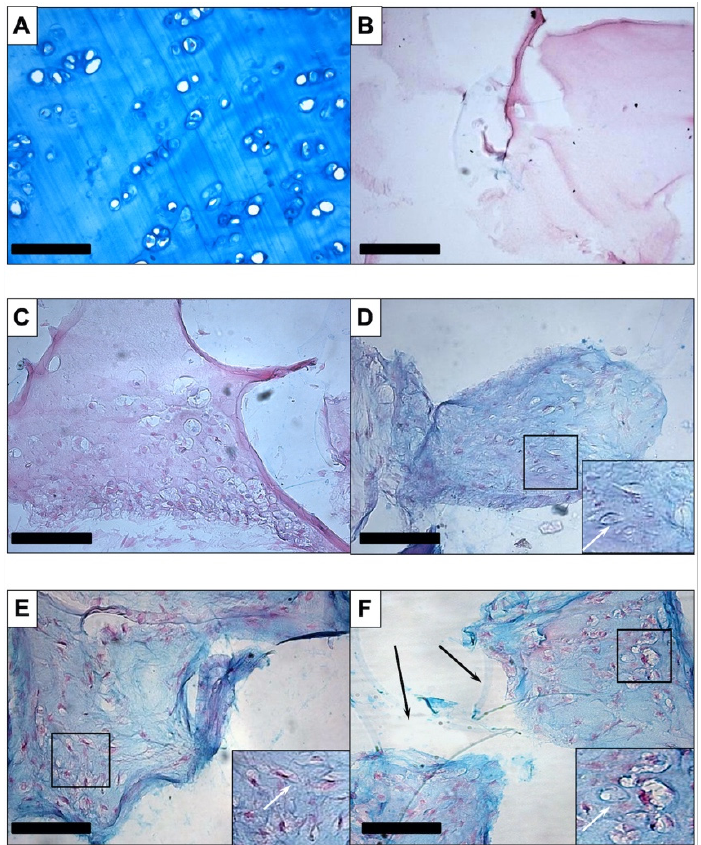
Figure 2. Alcian blue staining: Intense staining was seen in human septal cartilage, the positive control ( A ). PU-fibrin scaffolds without cells ( B ) and cell-seeded scaffolds maintained in EM-DMEM ( C ) revealed no blue staining. Chondrogenic differentiation in polyurethane-fibrin composites was verified by the detection of acid glycosaminoglycans in the extracellular matrix, apparent as extracellular blue-turquoise colouration in the growth factor-treated groups BBT ( D ), BT ( E ), and TI ( F ). Another interesting finding was scattered cartilage lacunae-like structures in the sections of chondrogenic-induced ASC-seeded PU fibrin constructs. Corresponding marked areas were shown enlarged in inserted smaller pictures.The white arrows highlight enhanced staining in the marginal area of the structures. Polygonal, clear sections of the polyurethane foam are highlighted by black arrows in 2F. Magnification is × 200 in all figures; the scale bar represents 100 μ m.